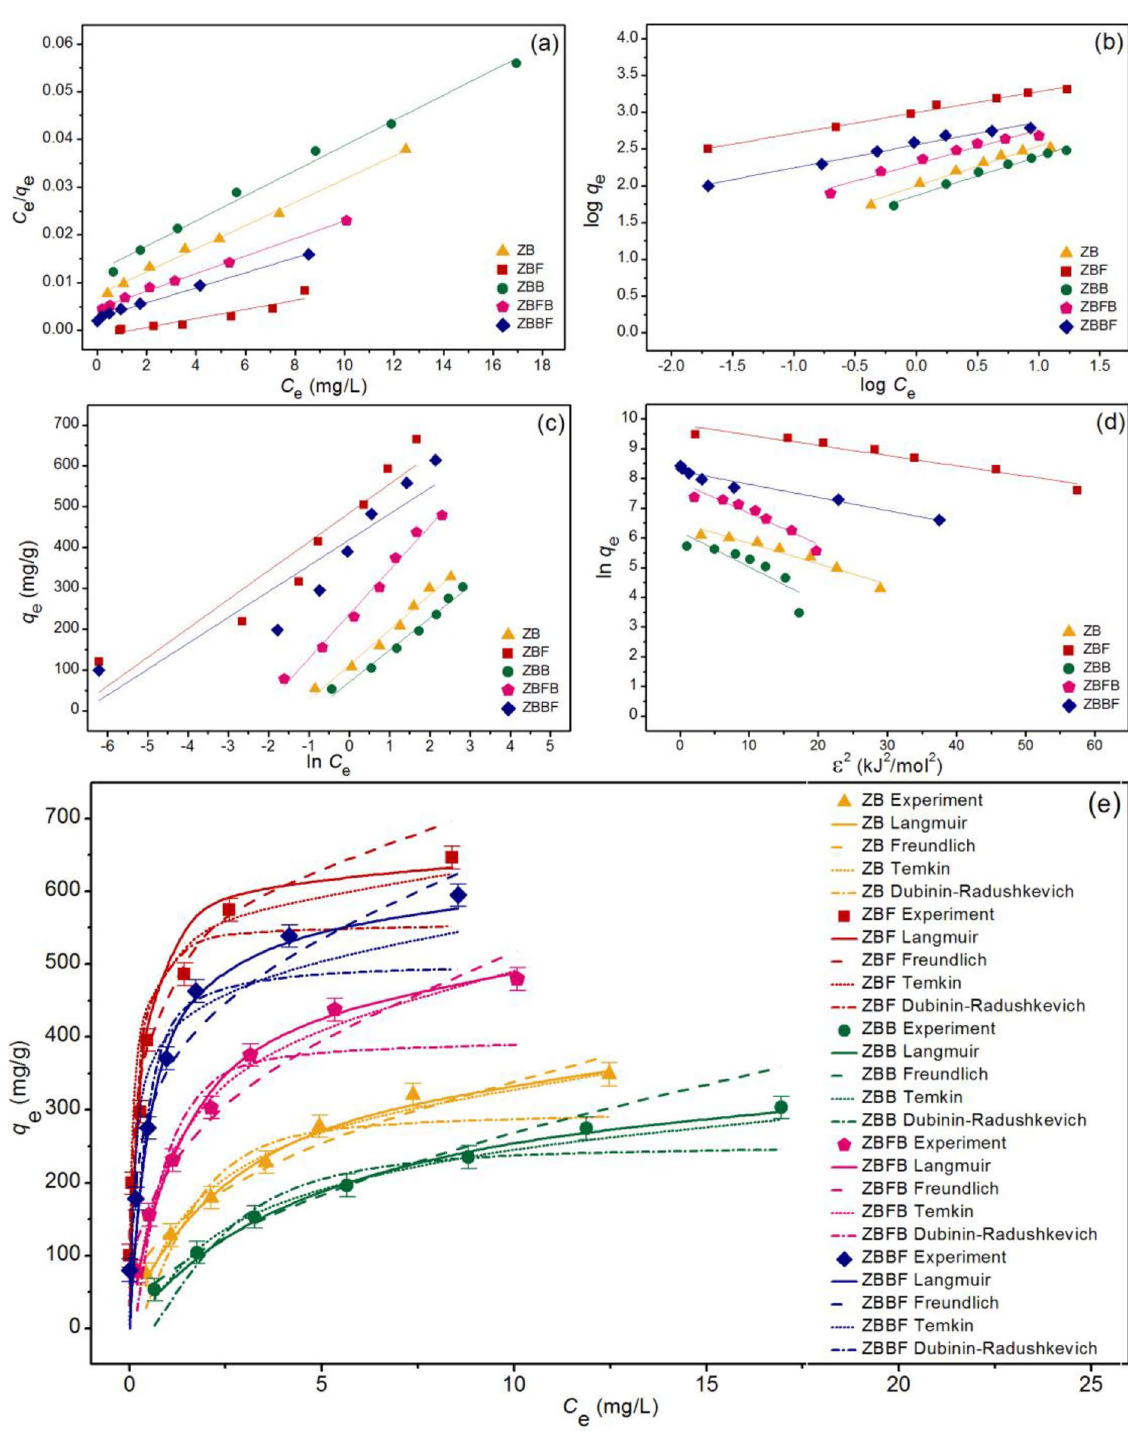
Figure 8. Graphs of ( a ) linear Langmuir, ( b ) linear Freundlich, ( c ) linear Temkin, ( d ) linear Dubinin– Radushkevich, and ( e ) nonlinear adsorption isotherms of zeolite A sugarcane bagasse fly ash powder (ZB), zeolite A sugarcane bagasse fly ash powder mixed iron(III) oxide-hydroxide (ZBF), zeolite A sugarcane bagasse fly ash beads (ZBB), zeolite A sugarcane bagasse fly ash powder mixed iron(III) oxide-hydroxide beads (ZBFB), and zeolite A sugarcane bagasse fly ash beads coated iron(III) oxide-hydroxide (ZBBF) for lead